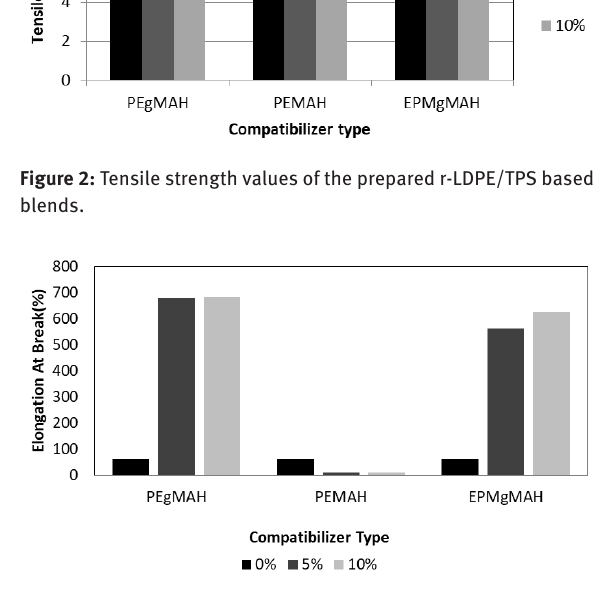
Figure 3: Elongation at break values of prepared r-LDPE/TPS based blends.